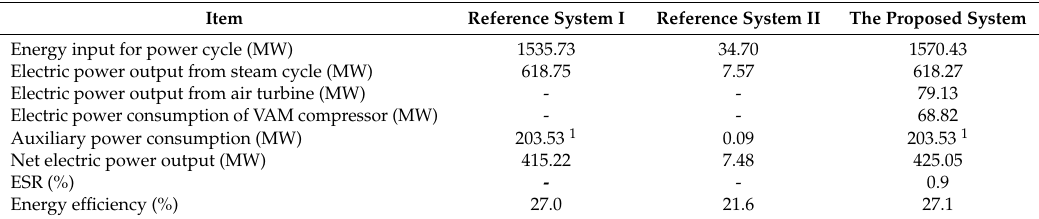
Table 8. Thermodynamic performance of the reference systems and the proposed system.